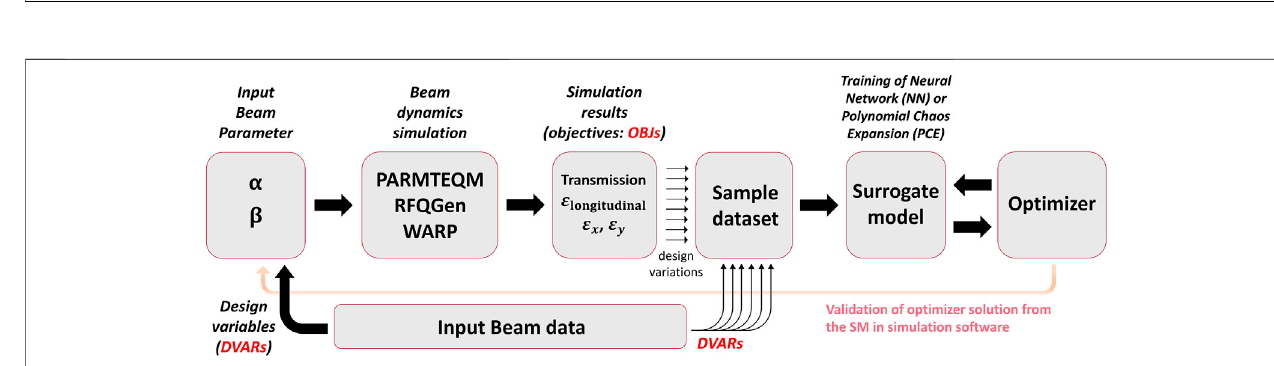
FIGURE 3 | General machine learning optimization scheme for RFQ beam dynamics.